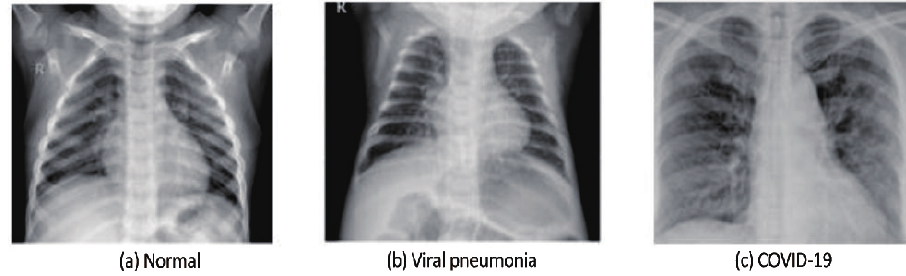
Fig. 3 Sample images of normal, viral pneumonia, and COVID-19 infected patients [9]